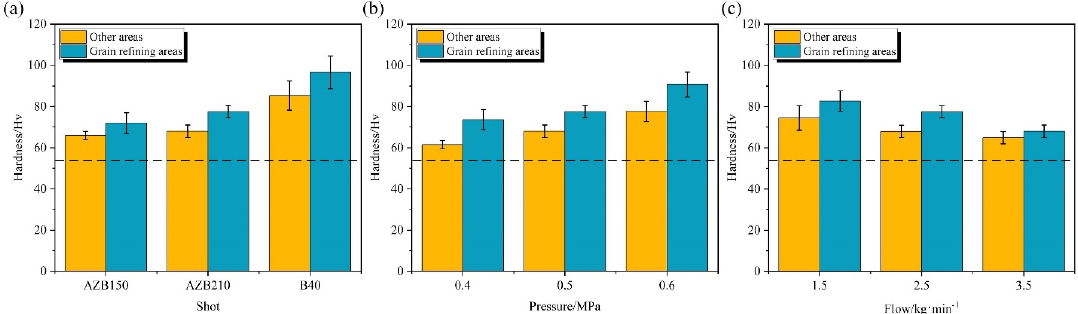
Figure 13. Microhardness comparison of coatings under varying working conditions: ( a ) shot size; ( b ) shot-peening pressure; ( c ) shot-peening flow rate. ( b ) shot-peening pressure; ( c ) shot-peening flow